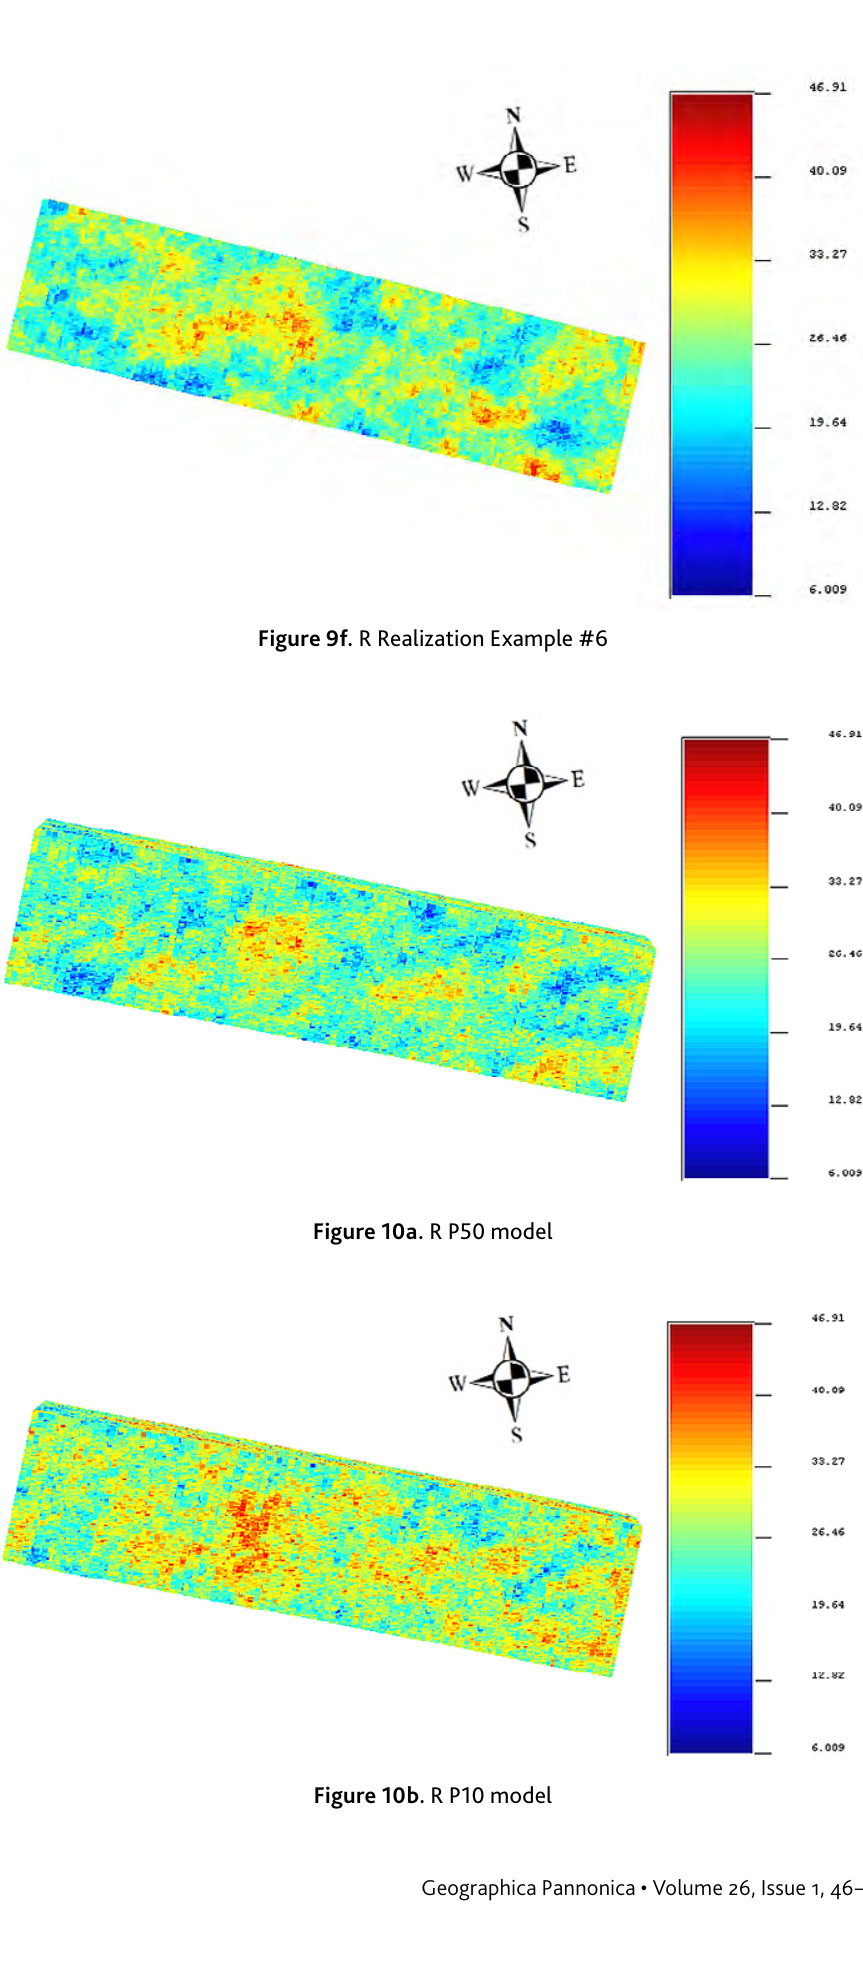
Figure 10b. R P10 model